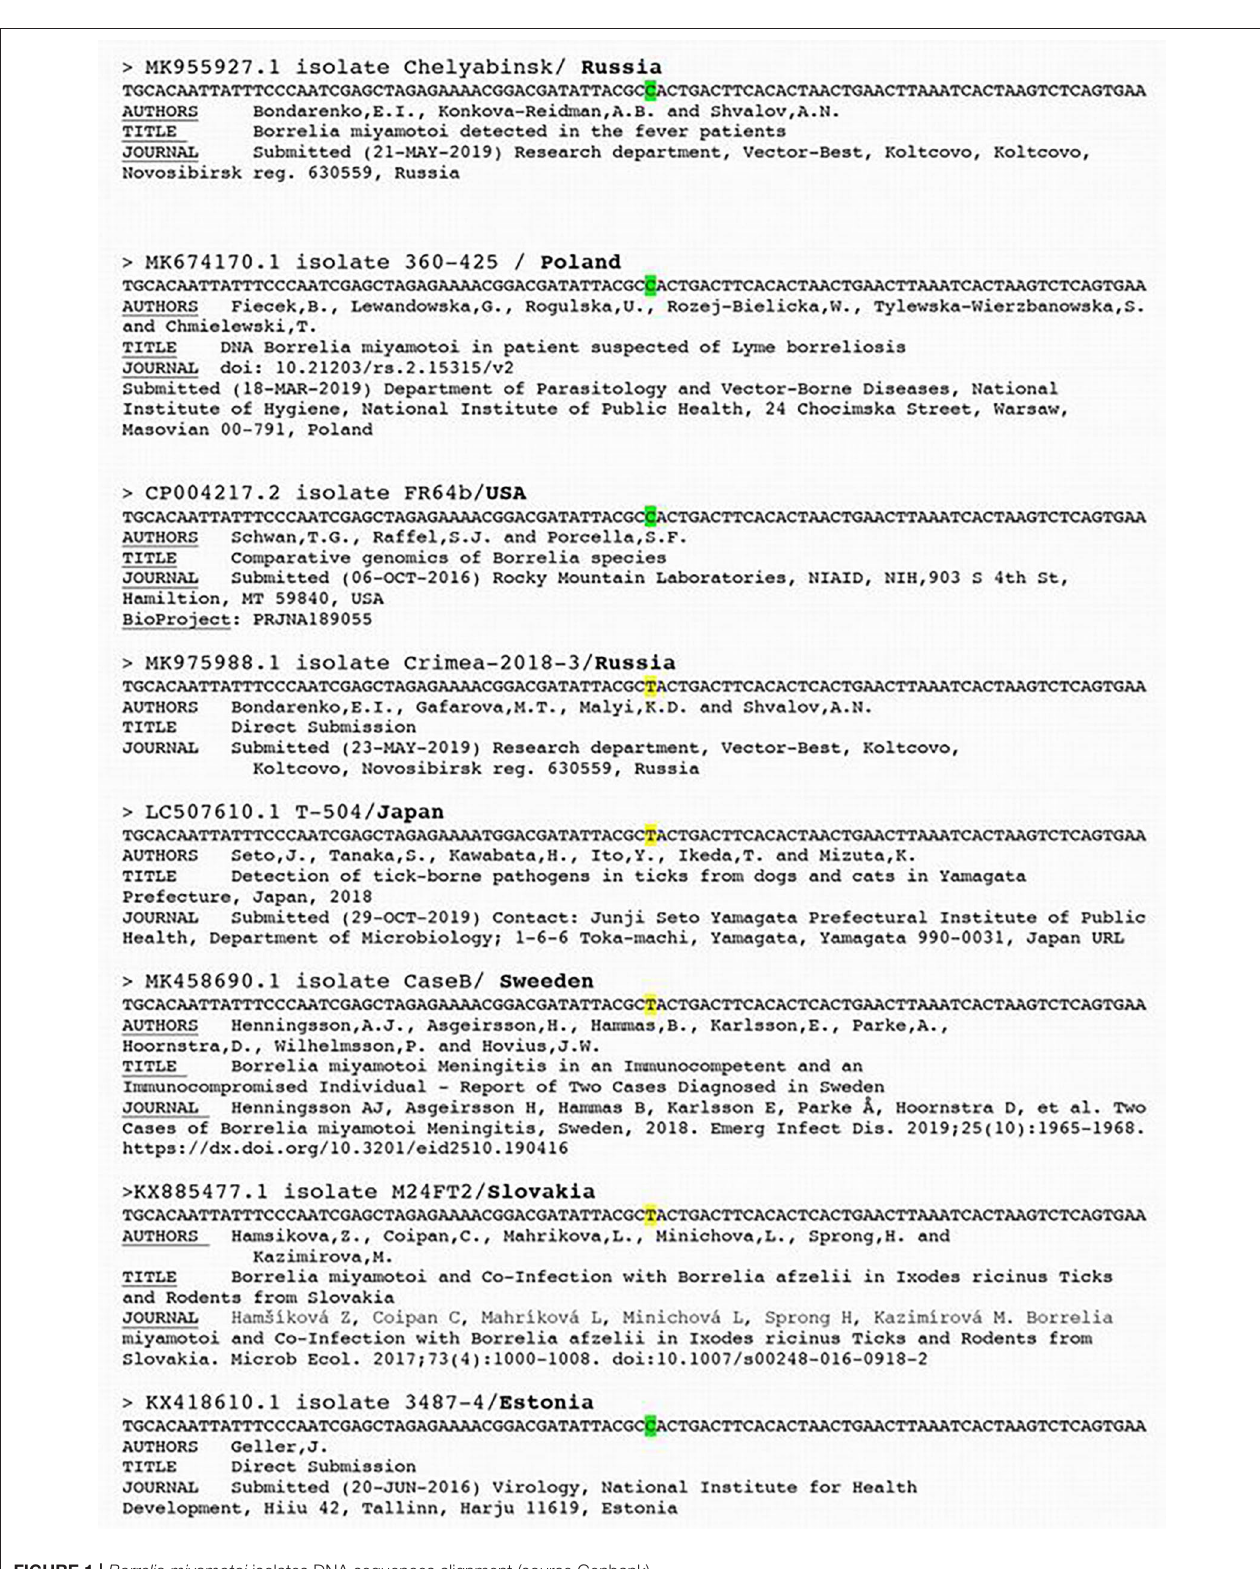
Frontiers in Medicine |